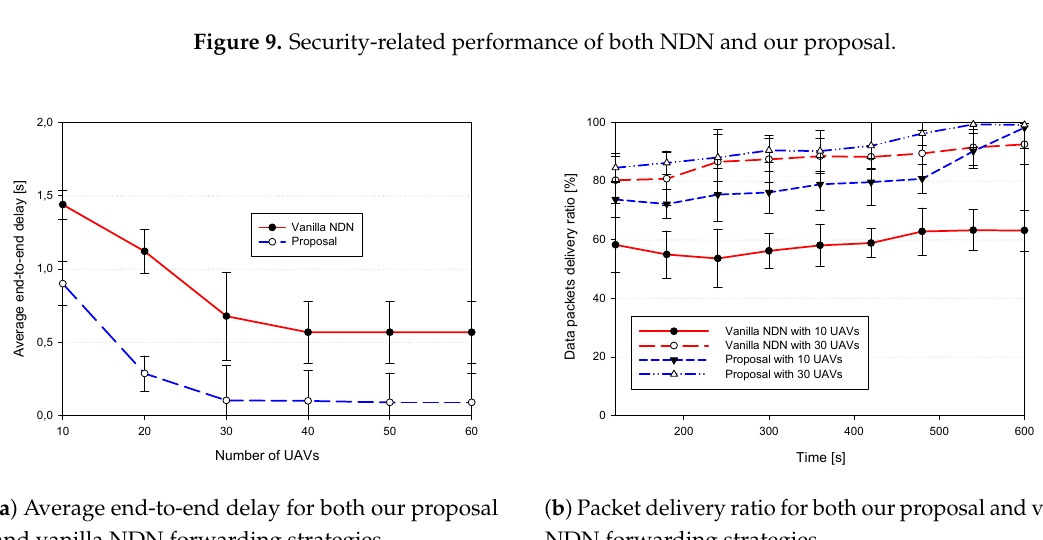
Figure 10. Network-related performance of both Vanilla NDN and our